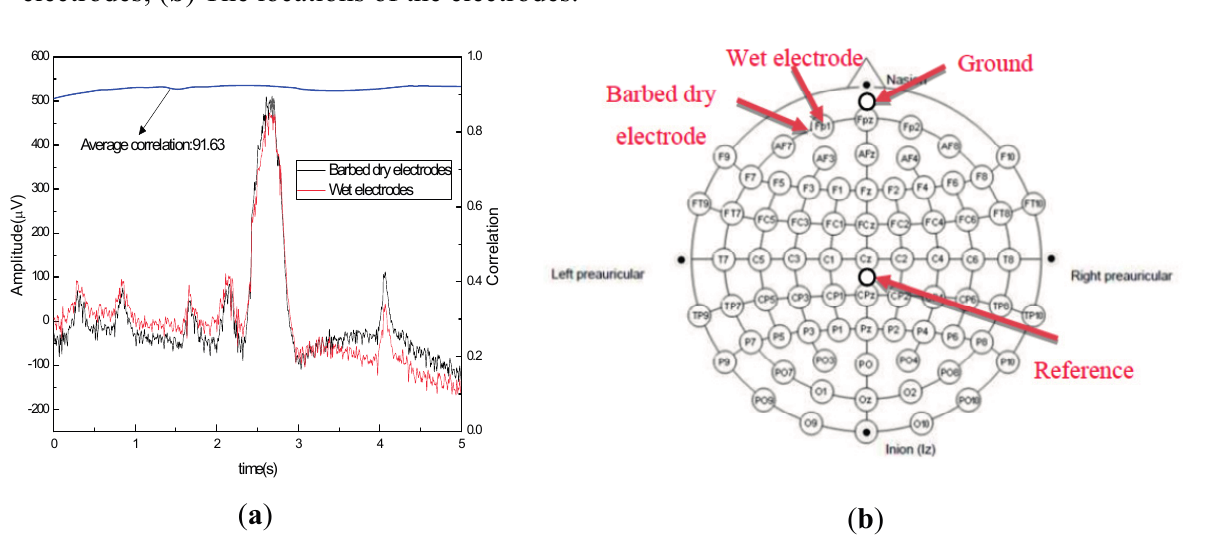
Figure 14. ( a ) EEG signals obtained using the conventional wet electrodes and barbed dry electrodes; ( b ) The locations of the electrodes.